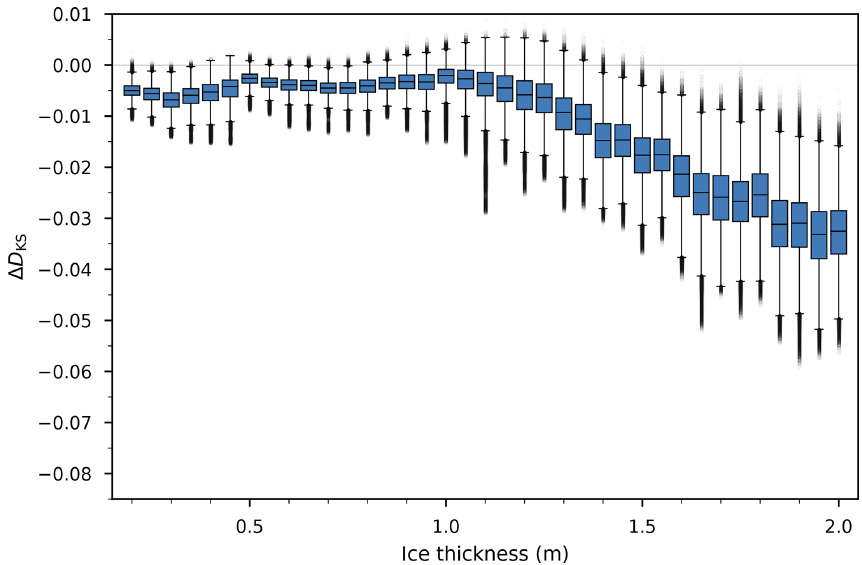
Figure D2. Same as Fig. D1 for varying ice